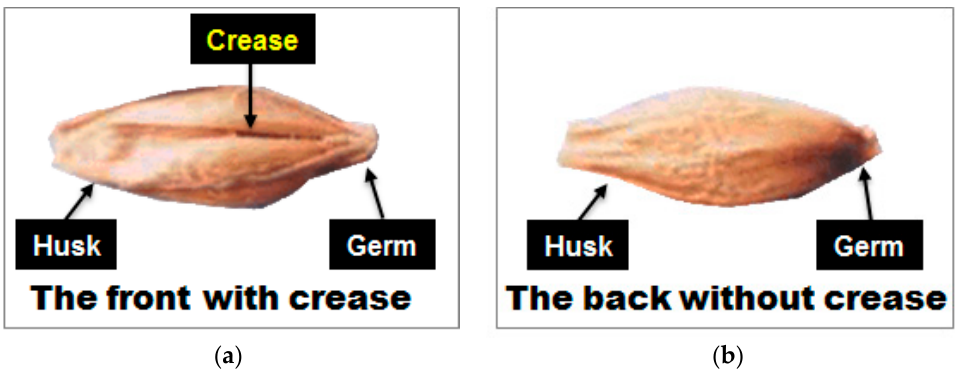
Figure 3. Denotation of ( a ) front side and ( b ) back side of hulled barley by the presence of the crease. As shown in Figure 4, the hulled barley kernels were transferred to the optimal samples template for measurements. The integration time was 200 ms, and the spectra were cumulatively averaged 3 times. The smoothing pretreatment was applied to the basic reflectance spectra.